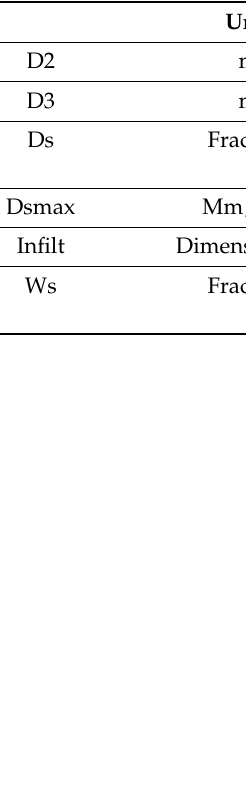
Table 1. Ranges and final values of VIC calibration